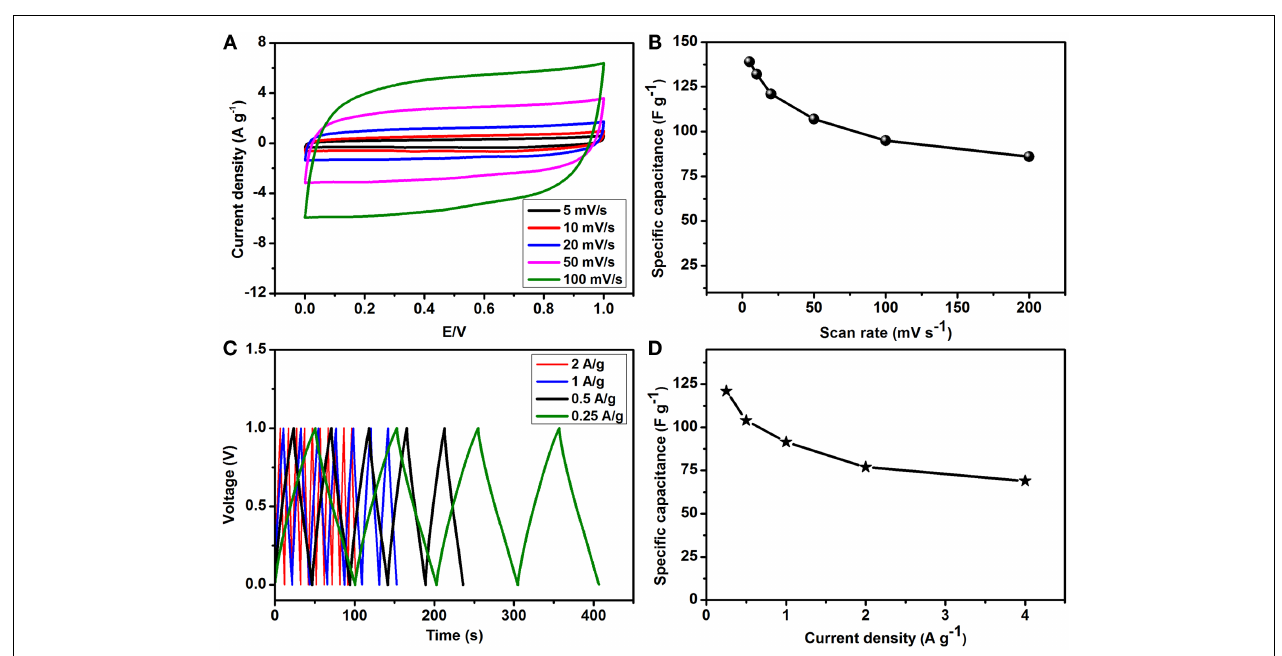
FIGURE 7 | Electrochemical performance of the as-prepared rGO–PP 25 composite in an asymmetric supercapacitor device: (A) effect of scan rates on the specific capacitance ( C s ), (B) variation of specific capacitance at different scan rates, (C) charge/discharge profiles at different current densities, and (D) variation of specific capacitance ( C s ) at different current densities